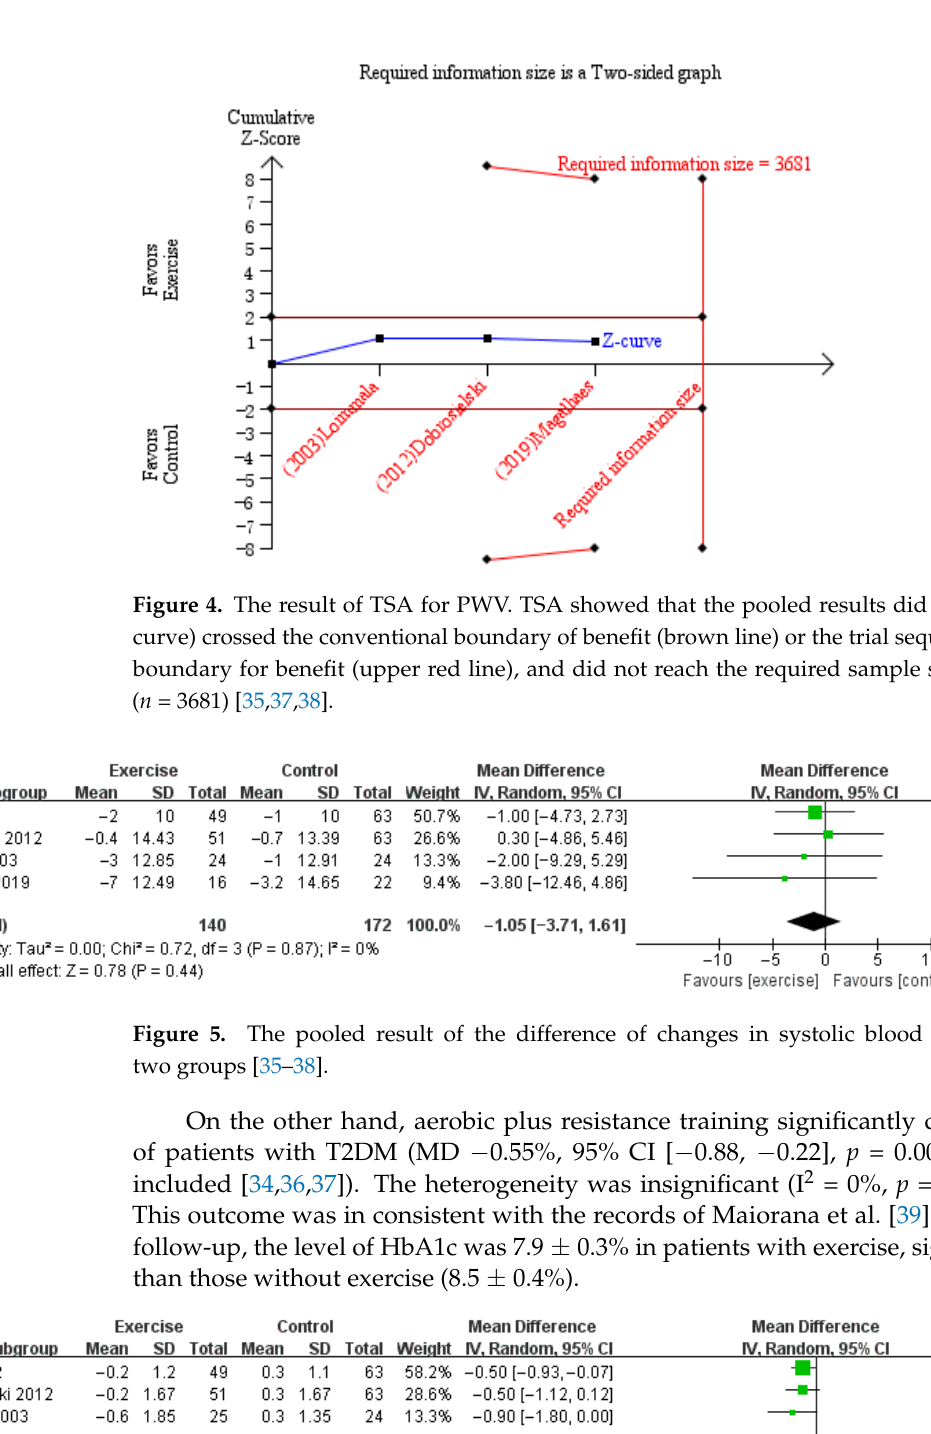
Figure 3. The pooled result of the difference of changes in pulse wave velocity between two groups [35,37,38].